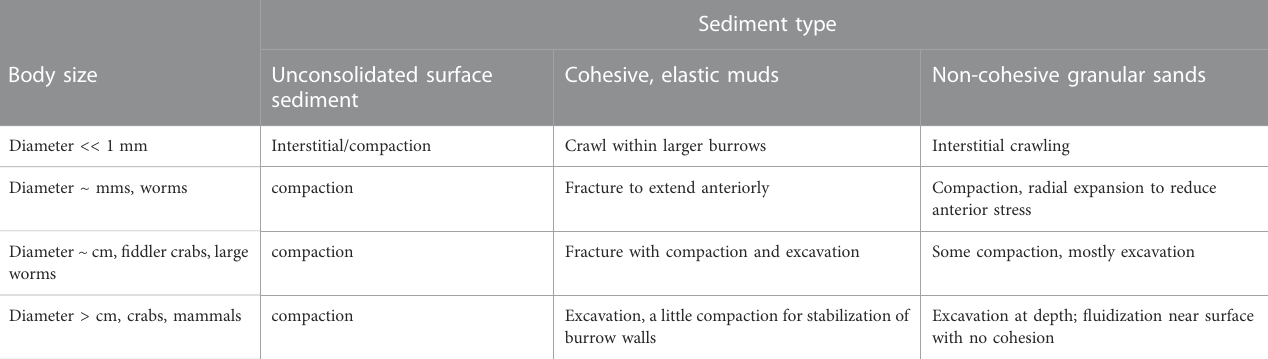
TABLE 1 Mechanisms to create burrows in different sediment types by animals of different body